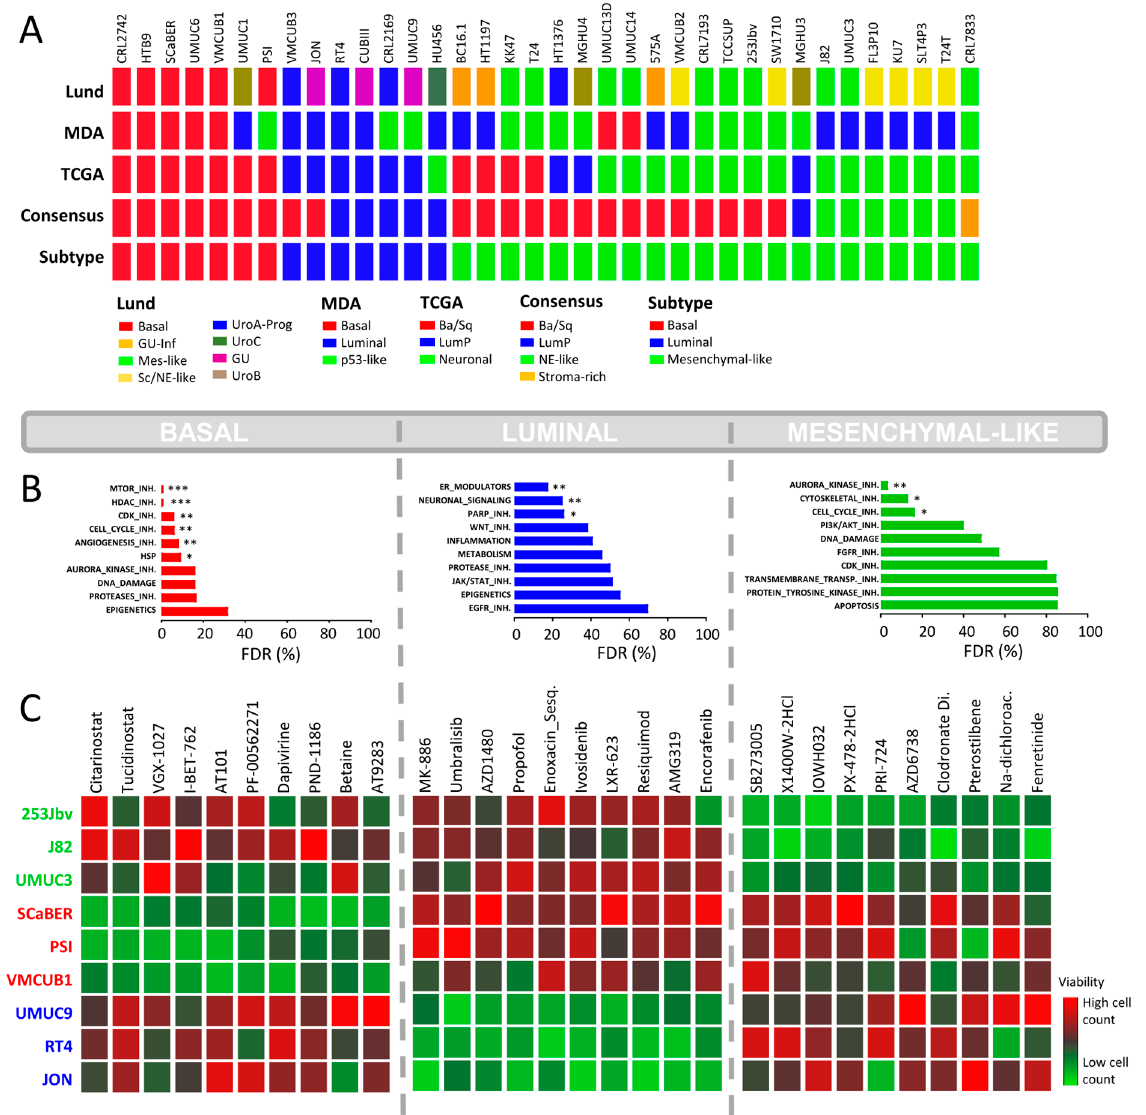
Figure 2. In-house BLA-40 cell line high-content drug screenings. ( A ) Subclassification of the BLA-40 cell lines ( n = 36) into the main known molecular BLCA subtype taxonomies: MDA, LUND, TCGA, and Consensus subtypes. The known subtypes converge into 3 main overlapping subtypes: basal, luminal, and mesenchymal-like. ( B ) Drug set enrichment analysis based on drug response data (percentage of cells alive) from the in-house HCS using 616 clinical inhibitors. Drugs were classified into 22 specific drug sets or classes. FDR = false discovery rate. ( p < 0.033: *, p < 0.002: **, p < 0.001: ***) ( C ) HCS based on 3 representative cell lines per subtype. The heatmaps indicate the top